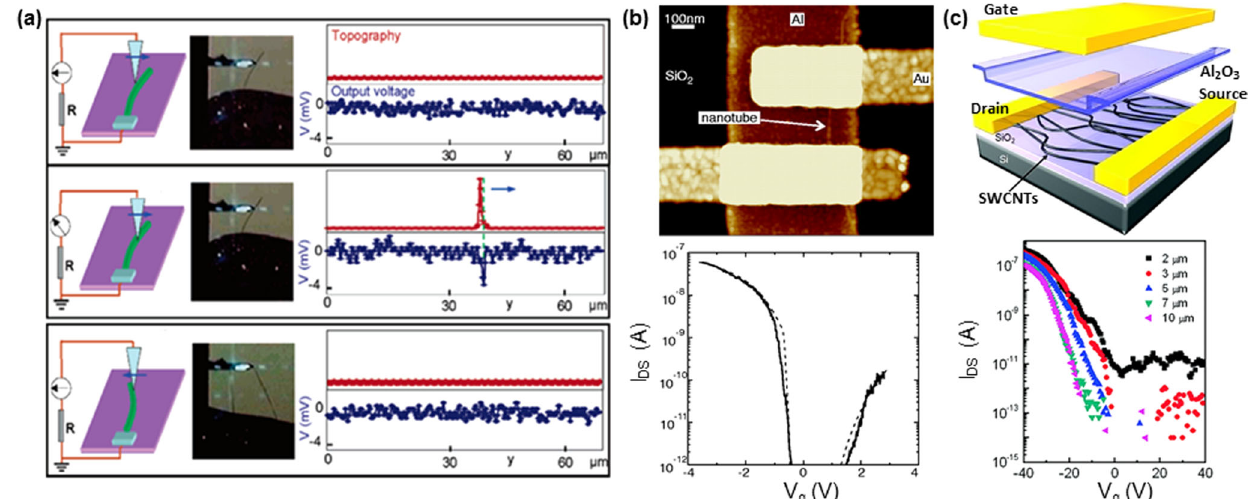
Fig. 2 Deformable 1D materials. a Schematic demonstration of the working principle of nanogenerators that are based on a single ZnO nanowire. The simultaneously recorded topology and electric response of the system indicate the piezoelectric current only forms when the AFM probe goes over the nanowire from one side to the other. Reprinted with permission from ref. 32. Field effect transistors (FETs) with b a single semiconducting carbon nanotube (CNT) or c a CNTs network as active channels. The lower panel shows the experimentally measured drain current as a function of gate voltage for a constant drain-source voltage of 5 mV ( b : a single CNT) and 100 mV ( c : a CNTs network for different channel lengths), respectively. FETs with a CNTs network active channel exhibit enhanced on/off ratio for an increased semiconducting channel length. b and c : Reprinted with permissions from refs. 35 and 38,